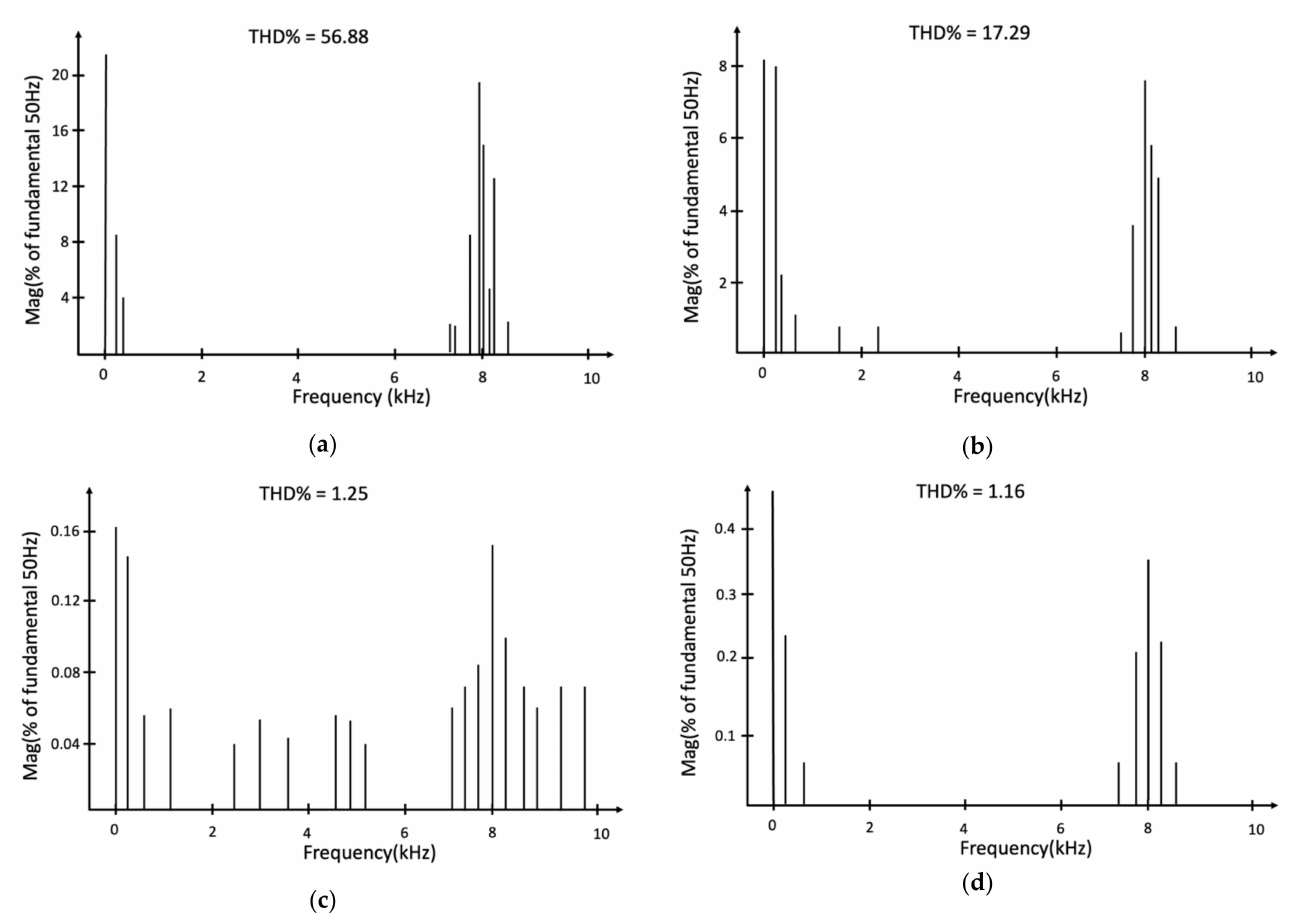
Figure 12. THD of the supply current: ( a ) without any filter action; ( b ) passive R-L-C filter only;